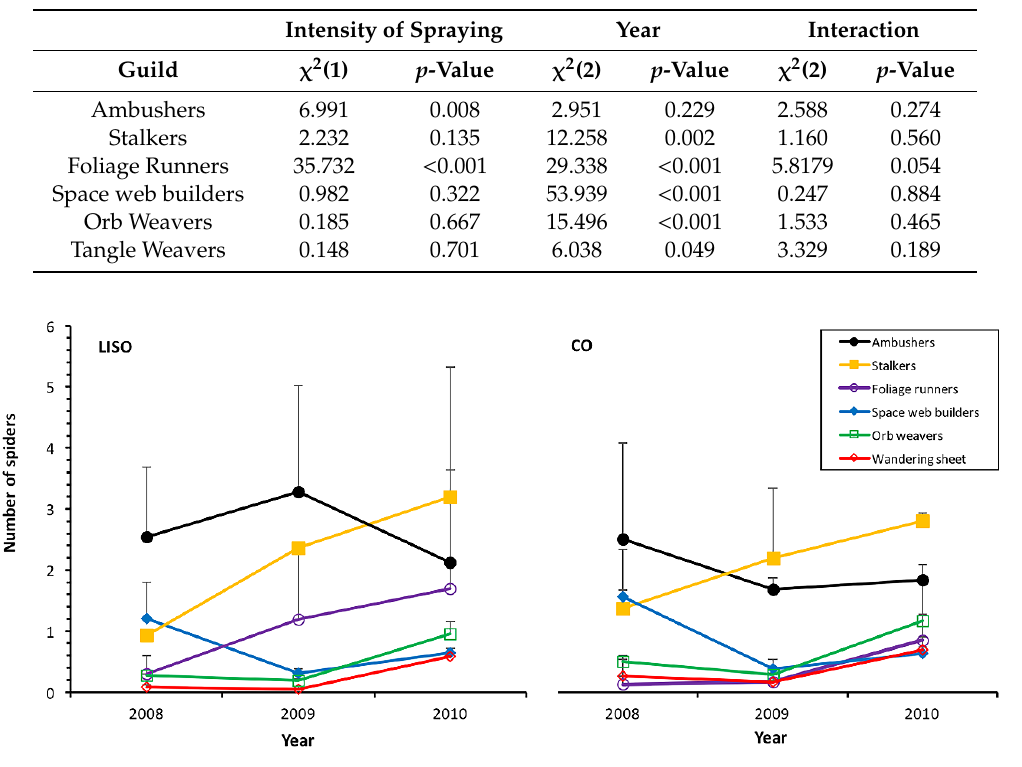
Figure 4. Annual abundance (mean ± SE, beating of 90 branches) of the different guilds of spiders in pear orchards over three years. LISO, low-intensity spraying orchards; CO, conventional orchards.